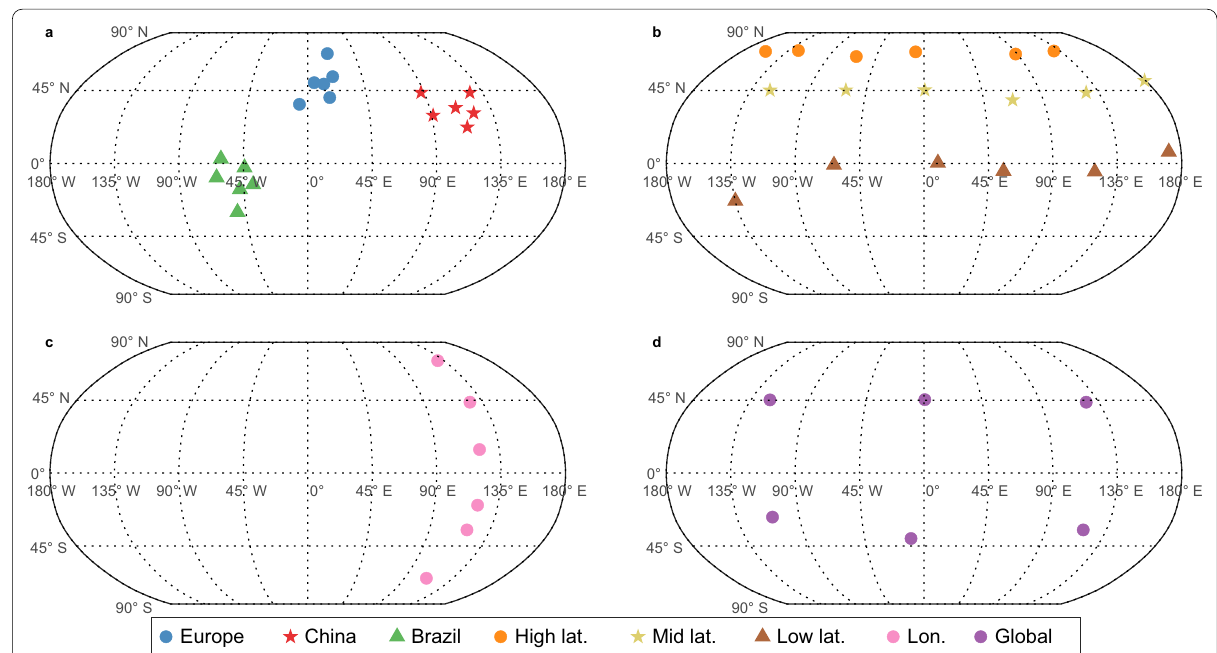
Fig. 2 Distribution of different ground networks: a regional, b quasi-global along latitudes, c quasi-global along longitude and d